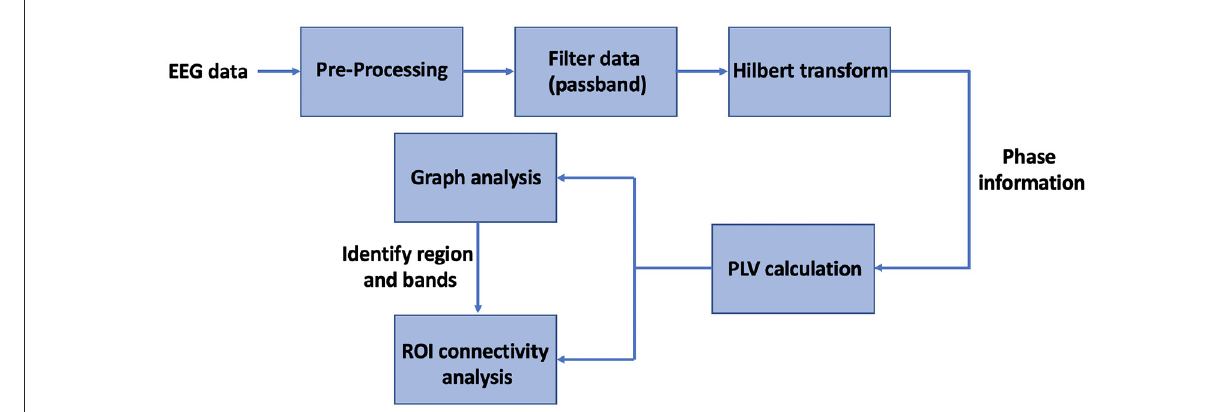
FIGURE2 Block diagram of the sequence of steps followed for the functional connectivity analysis.